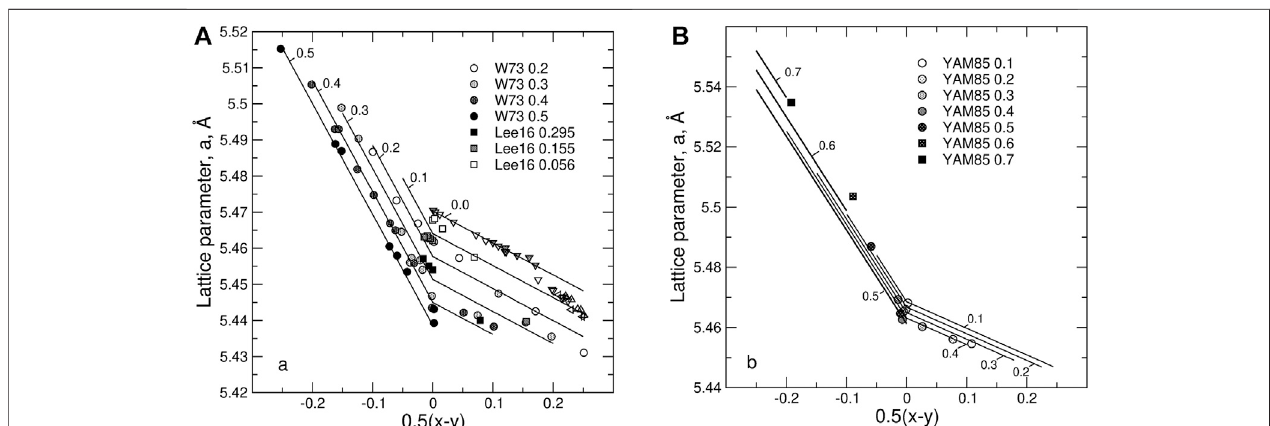
FIGURE6| Thedependenceofthelatticeparameteronnon-stoichiometry,0.5( x-y ),and z in (A) U 1- z Nd z O 2+0.5( x - y ) and (B) U 1- z Pr z O 2+0.5( x - y ) systems.Solidlinesare compositional isopleths predicted with the model. The experimental data (circles and squares) are from Wadier (Wadier, 1973) (circles), Lee et al. (Lee et al., 2016b) (squares), Yamashita et al. (Yamashita et al., 1985) (circles and squares are the samples synthesized at 1623 K), Lynds et al. (Lynds et al., 1963) (open down triangles), Belbeoch (Belbeoch et al., 1964) (shaded down triangles), Matsui and Naito (Matsui and Naito, 1975) (open up triangles), Schaner (Schaner, 1960) (left triangles), Grønvold (Grønvold, 1955) (shaded up triangles). The data on pure UO 2 obviously fall on two trends. The fi rst trend that extends from the stoichiometric UO 2 up to x ∼ 0.30 is assumed to represent the fl uorite-type solid solution. The trend extending to larger x values is assumed to represent U 4 O 9 -type structure. Thus, only the data from the fi rst trend were used in the fi